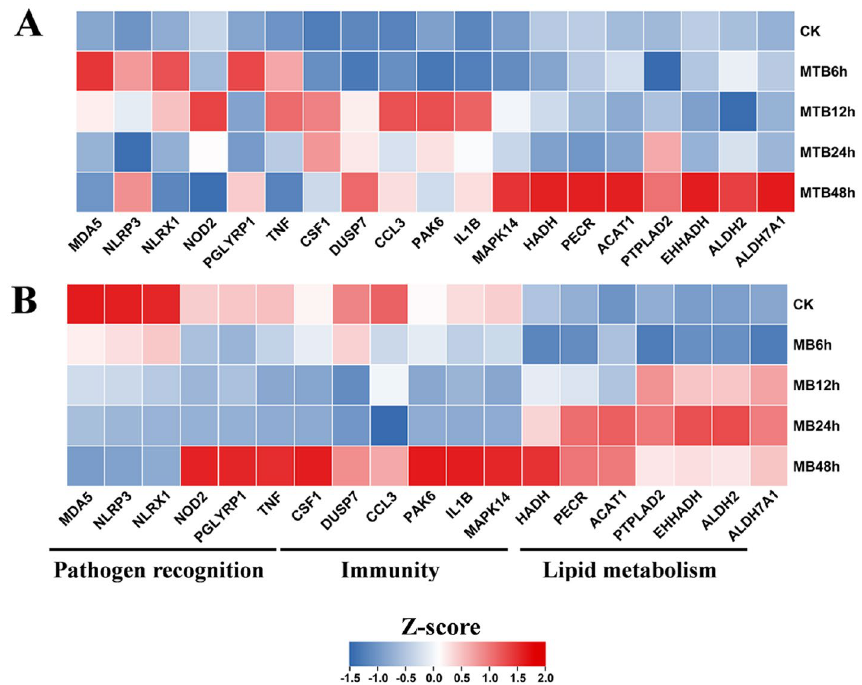
Figure 7. Estimation of the genes relevant to immunity, pathogen recognition and lipid metabolisms in BAM following MTB or MB challenges at time course. ( A ) Heatmap displays the expression levels of genes relevant to immunity, pathogen recognition and lipid metabolisms in MTB-infected BAM at time course. ( B ) The expression levels of representative genes in MB-infected BAM at time course. Scale represents the Z-score of normalized Foldchange value of each genes compared to CK (0 h infection). The up- and down-regulated genes are shown in red and blue, respectively. Two-tailed t tests are used for all statistical analysis, P <